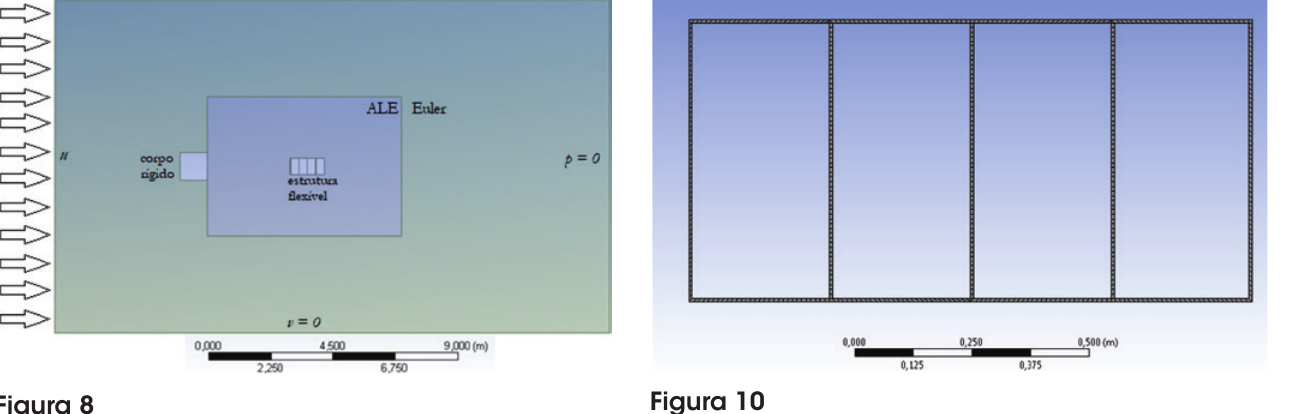
Geometria para o problema acoplado